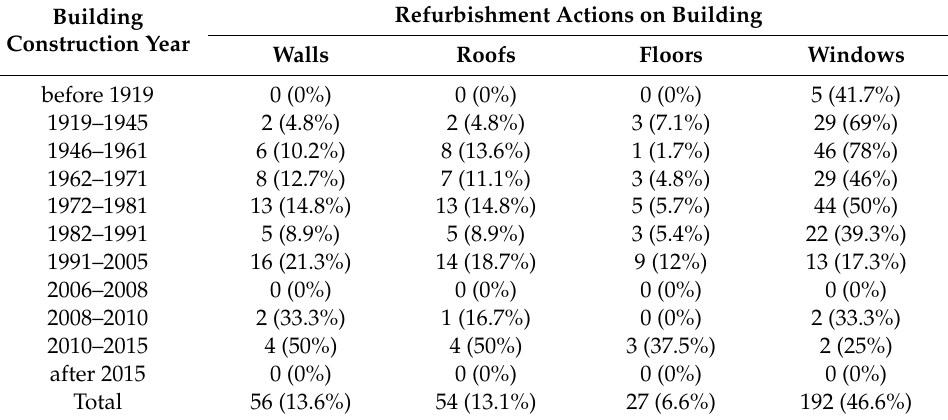
Table 2. Refurbishment actions on building.